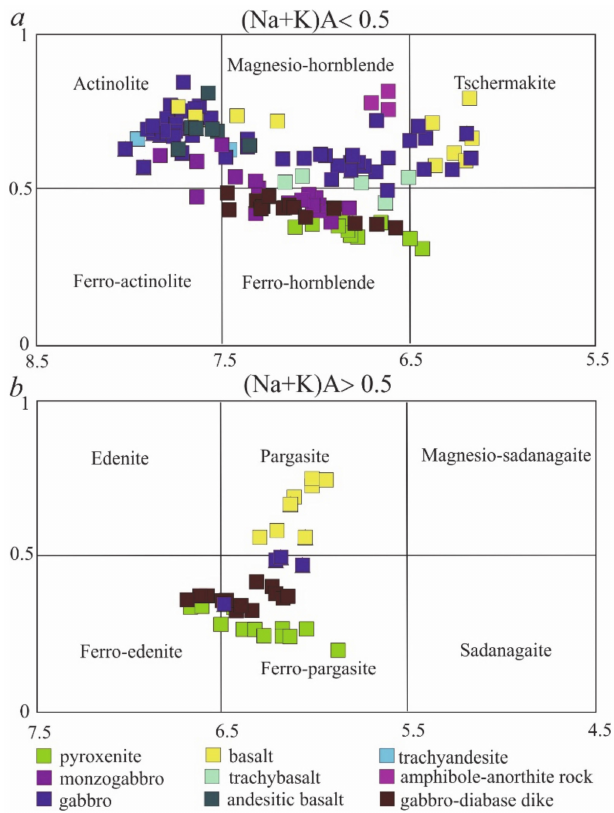
Figure 11. A nomenclature diagram [52] for